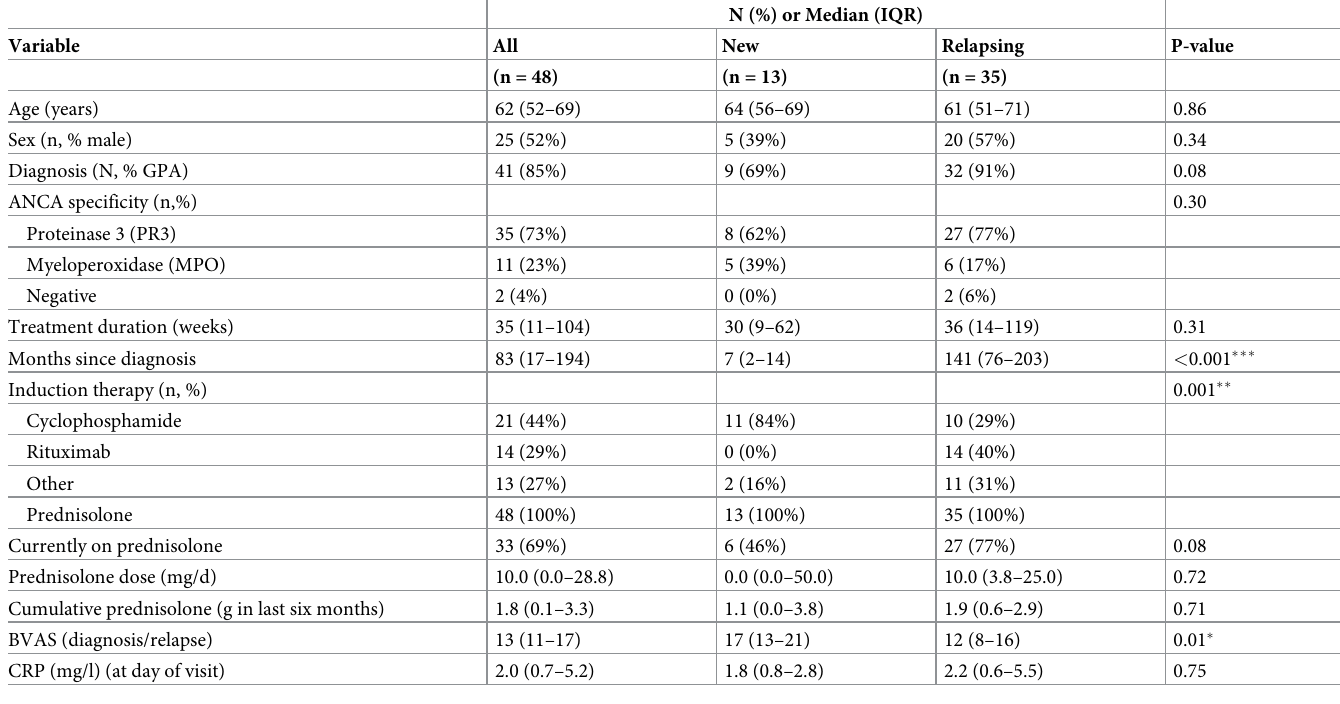
Table 1. Patient